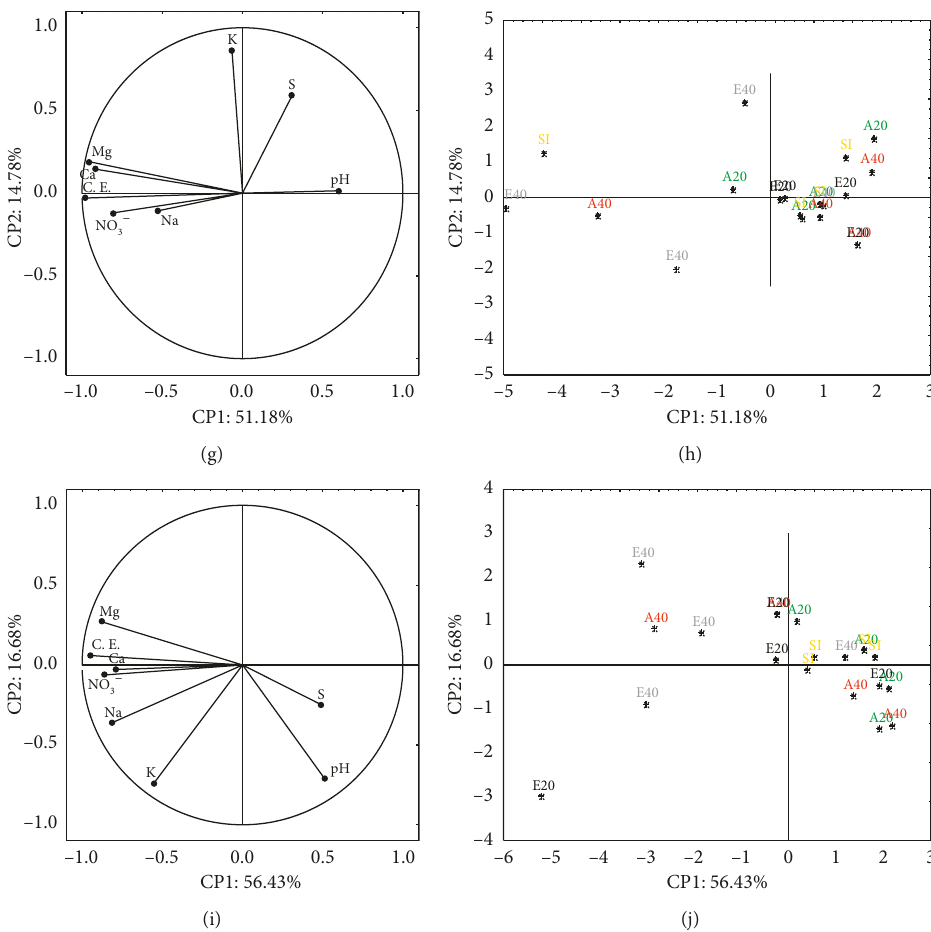
Figure 3: Two-dimensional representation (loadings-scores) of the principal component analysis for soil solution of each depth. (a, b) Extraction depth 0.10m; (c, d) draw depth 0.30m; (e, f) extraction depth 0.50m; (g, h) draw depth 0.70m; (i, j) draw depth